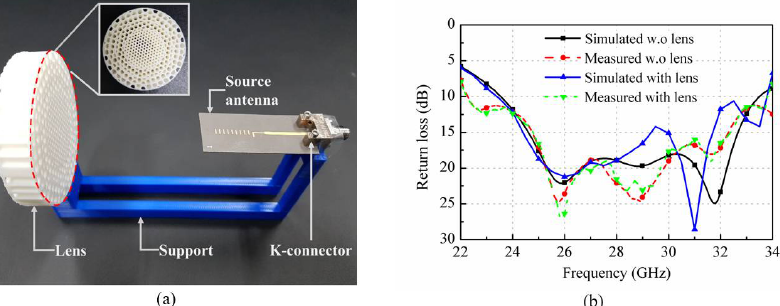
Figure 7. ( a ) Fabricated prototype fractal GRIN lens using honeycomb cells fed by Yagi antenna. ( b ) Simulated and measured return loss for Yagi antenna and Yagi antenna with proposed fractal GRIN lens.